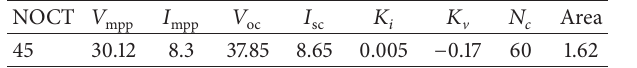
Table 1: Data sheet parameters of 250 Wp PV panel.